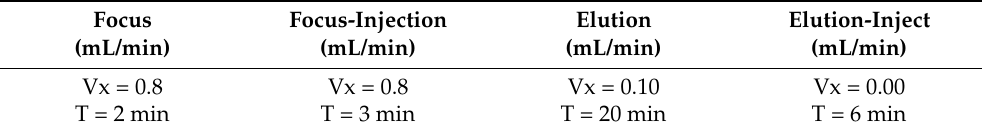
Table 2. Flow conditions used for the HF5 analyses of PDA and